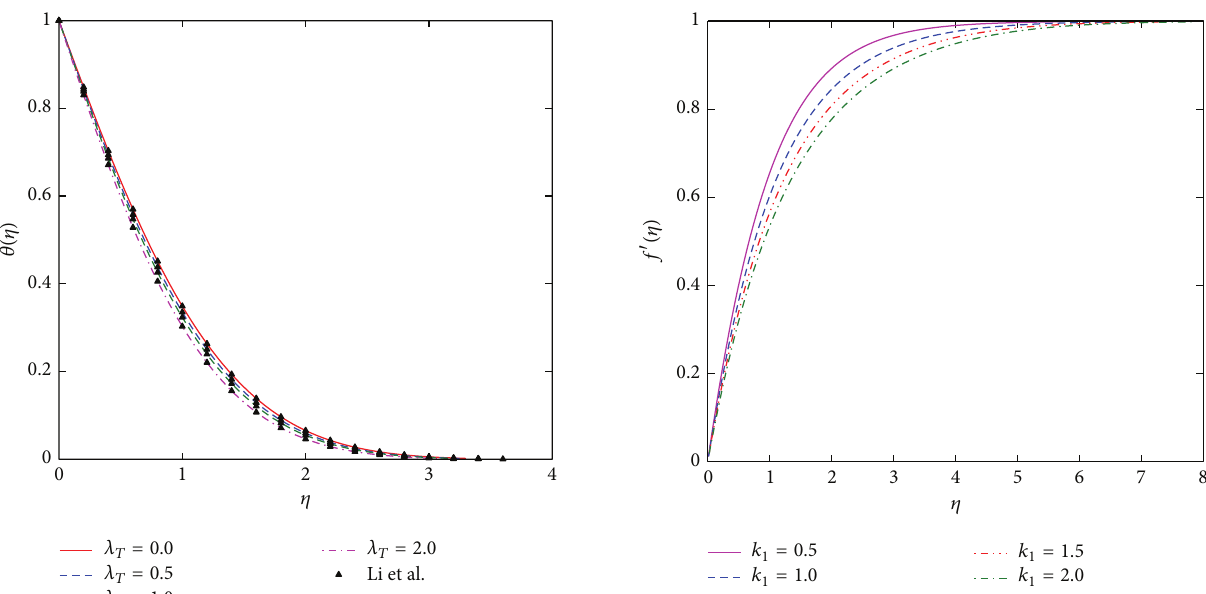
Figure 4: Verification of the results 𝜃(𝜂) with the previously pub- lished paper by Li et al. when 𝑘 1 = 0.3 , 𝑚 = 1.0 , and Pr = 1.0 .